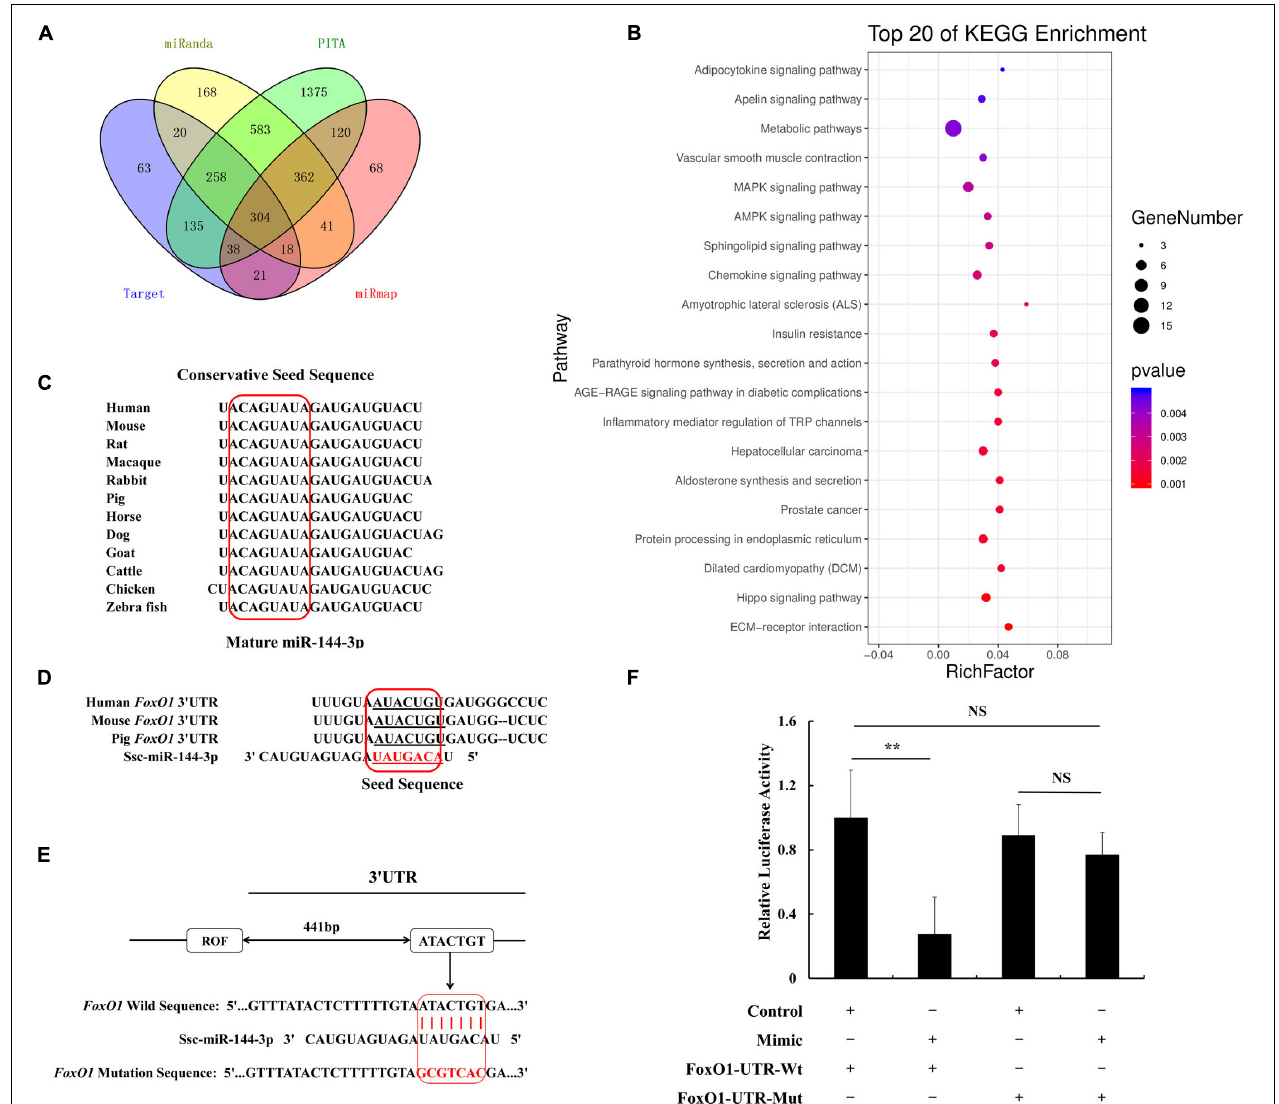
FIGURE 2 | MiR-144 targets FoxO1 by binding in its 3 (cid:48) UTR. (A) The Venn diagram of target genes prediction data. (B) Top 20 KEGG enrichment that predicted genes by Venn diagram. Dot means genes number, and the color means P -value. (C) Conservation estimation of mature miR-144 sequences within different species. (D) Conservation estimation of miRNA response elements (MREs) between human, mouse, and pig. (E) The location of miR-144 MREs in porcine FoxO1 gene 3 (cid:48) UTR. (F) The results of dual fluorescence activity detection of miR-144 targeting FoxO1. ** p < 0.01.